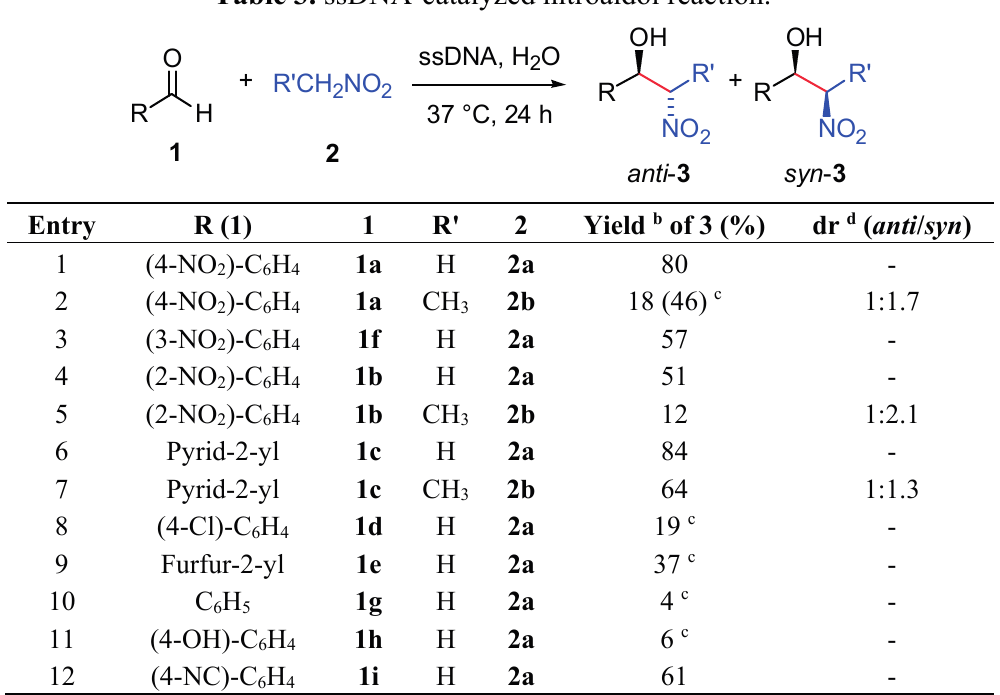
Table 3. ssDNA-catalyzed nitroaldol reaction.